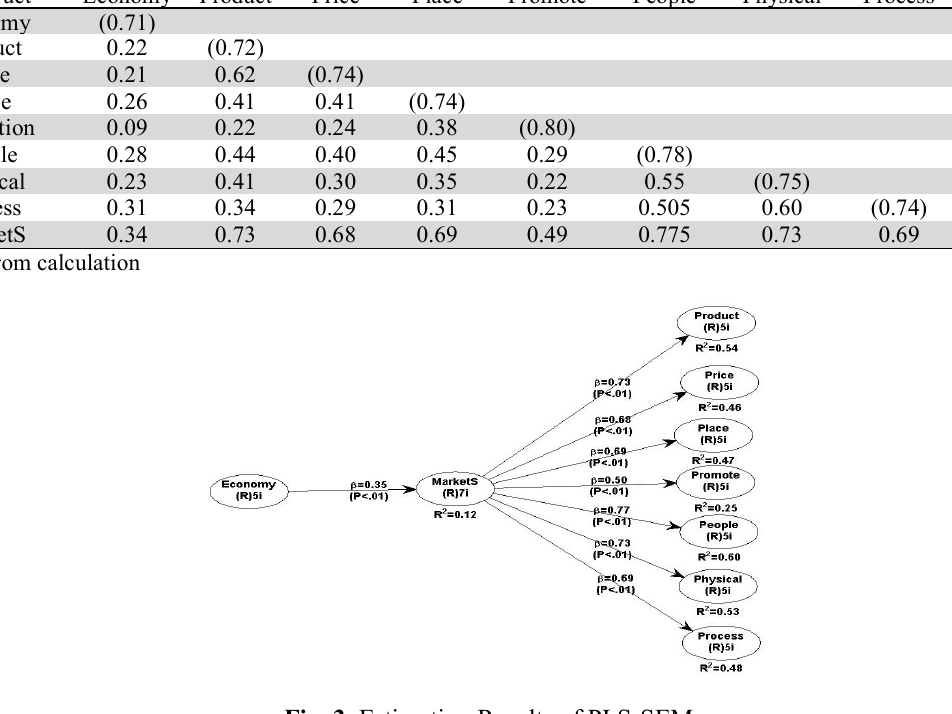
Fig. 3. Estimation Results of